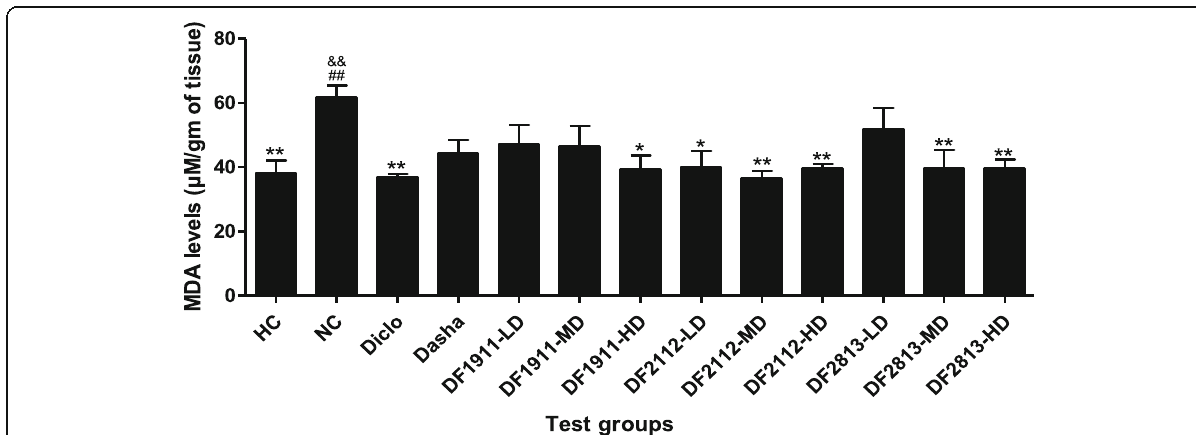
Fig. 2 MDA levels in liver tissue. HC: Healthy control, NC: Negative control, Diclo: Diclofenac sodium, Dasha: Dashamoola Kwatha , DF: Dashamoola Formulation, LD: Lower dose, MD: Middle dose, HD: Higher dose. Values are expressed as Mean ± SEM; n = 6. Data were analysed by One-Way ANOVA followed by Dunnett ’ s multiple comparison test. * = p < 0.05, ** = p < 0.01 when compared to NC; && = p < 0.01 when compared to